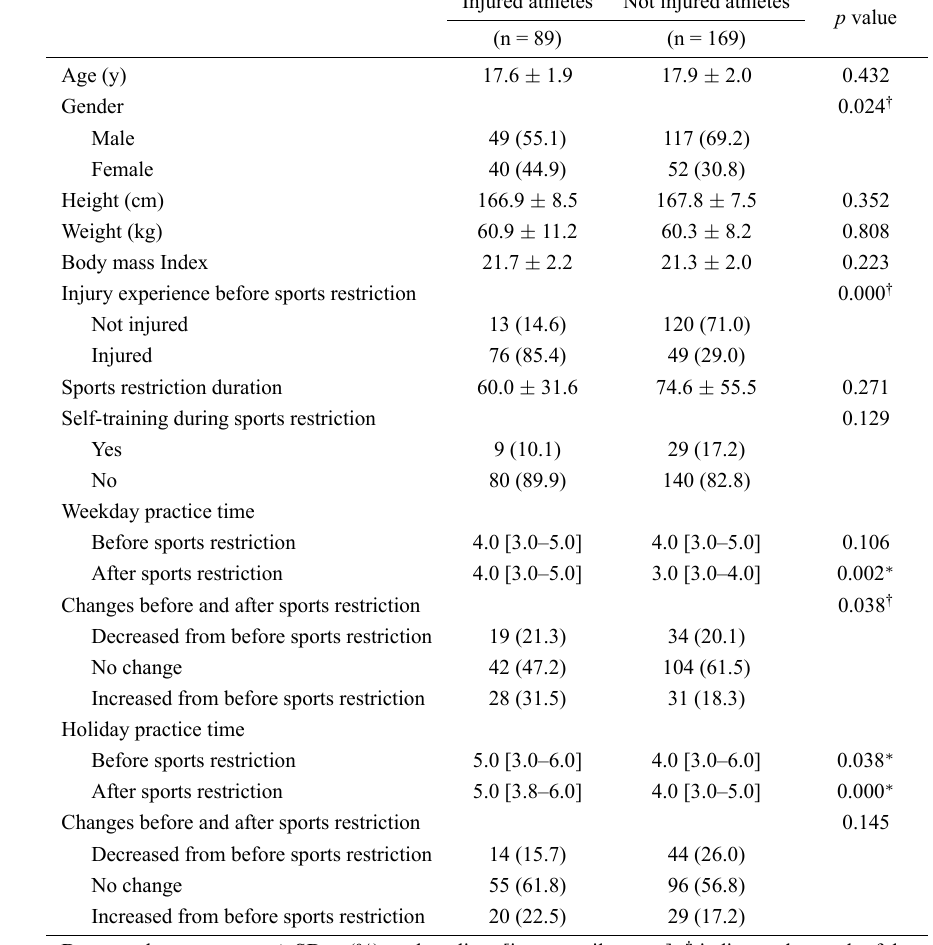
Table 1. Comparison of injured and non-injured athletes after returning to sports following the COVID-19 restrictions.